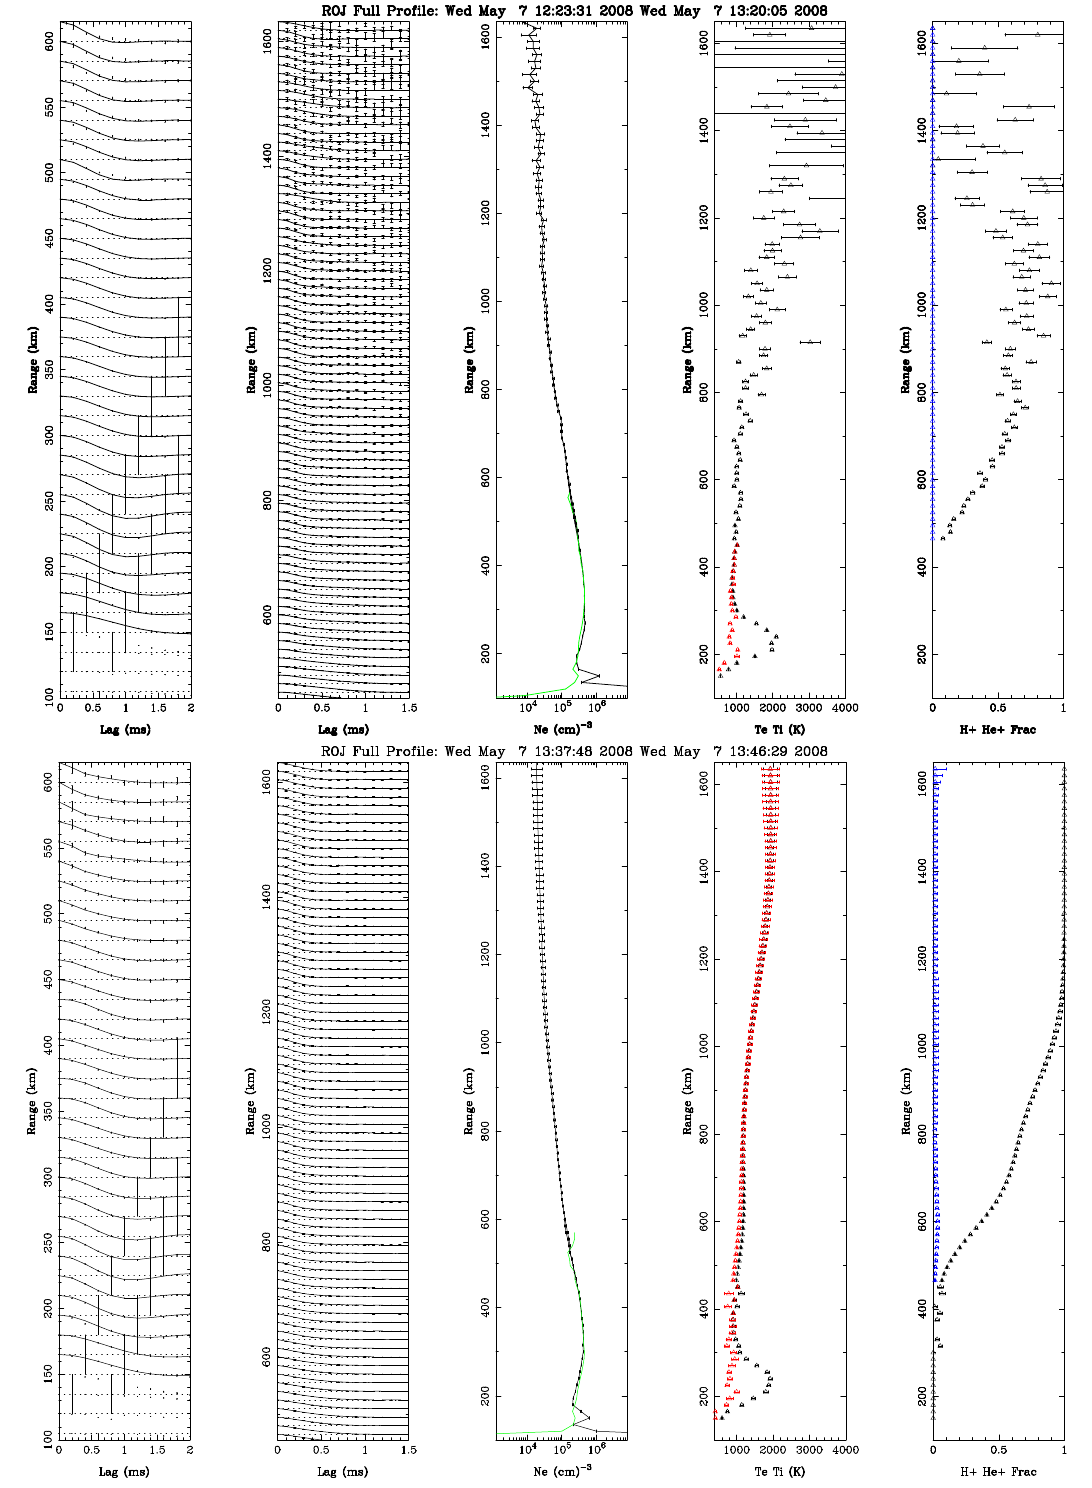
Fig. 3. Figures comparing alternating coded-pulse (upper half) and long-pulse/full-profile (lower half) results obtained on 7 May 2008. The incoherent integration times involved in the analysis were approximately 1h and 10min.,